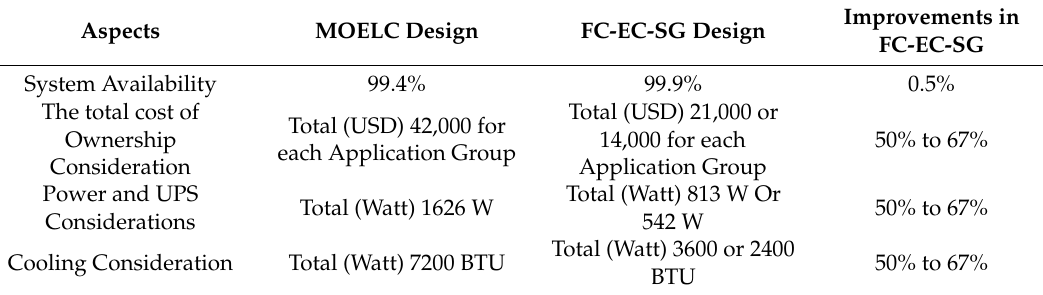
Table 8. Summary of performance